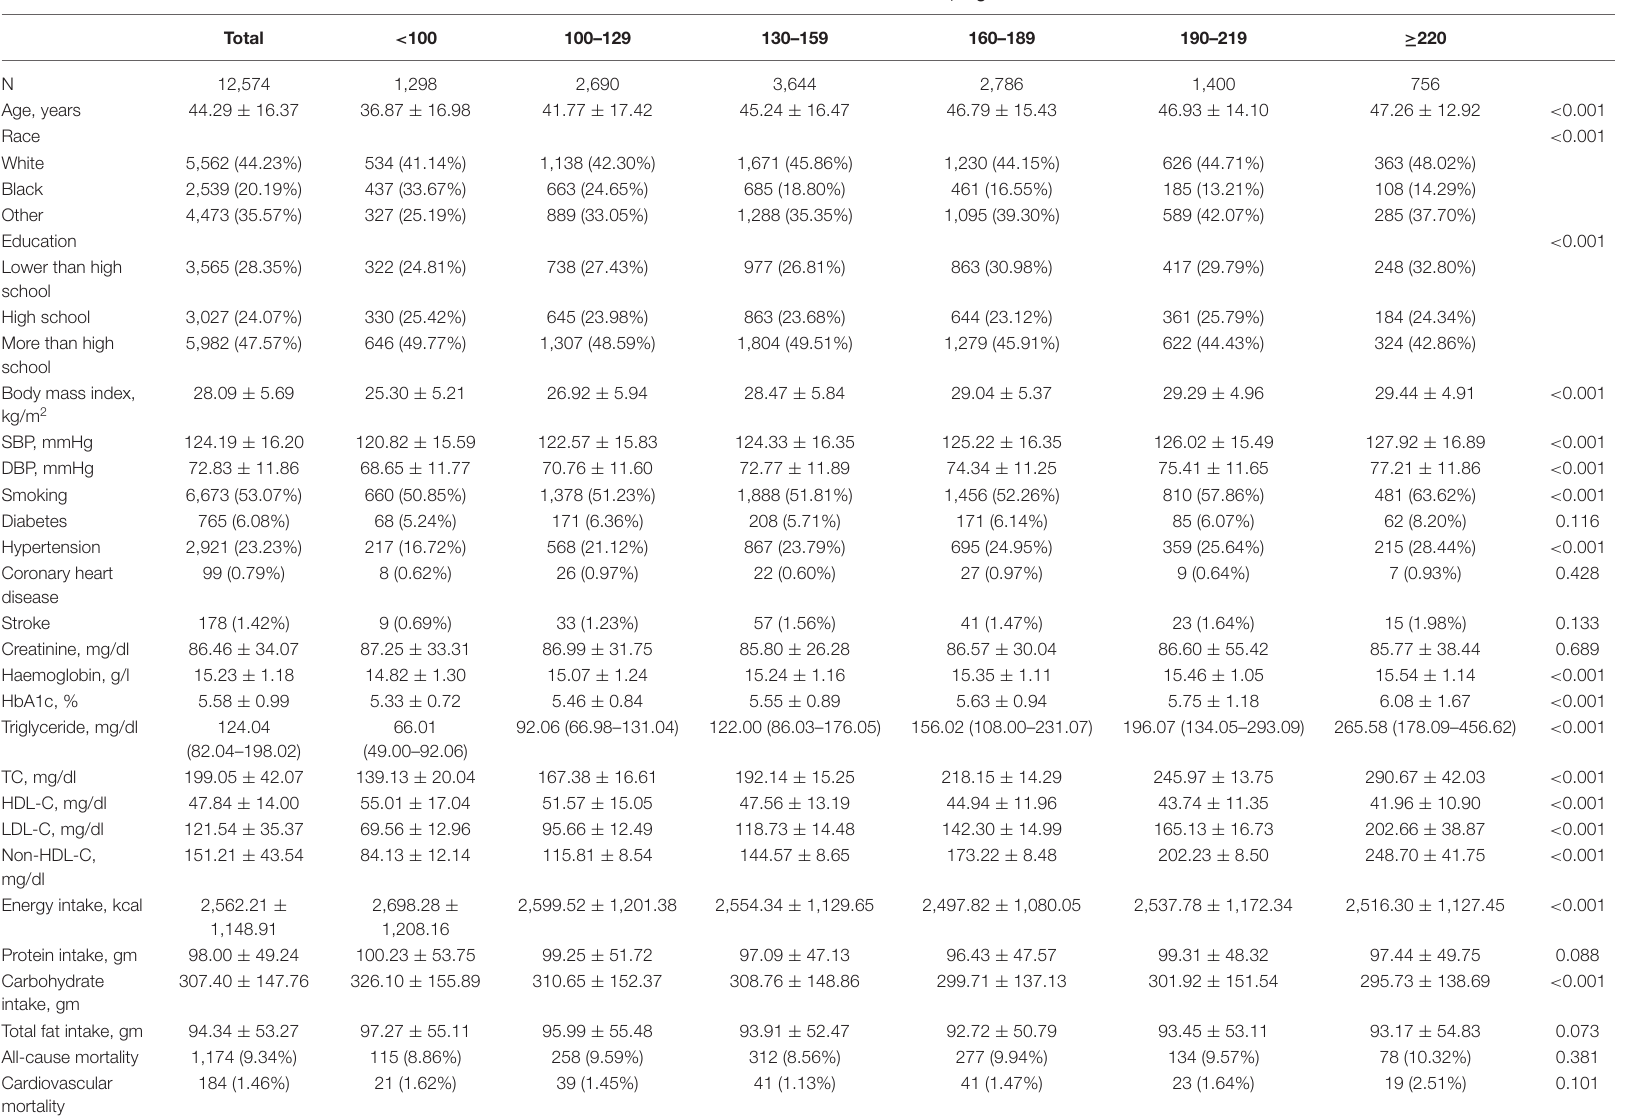
TABLE 1 | Baseline characteristics according to non-HDL-C